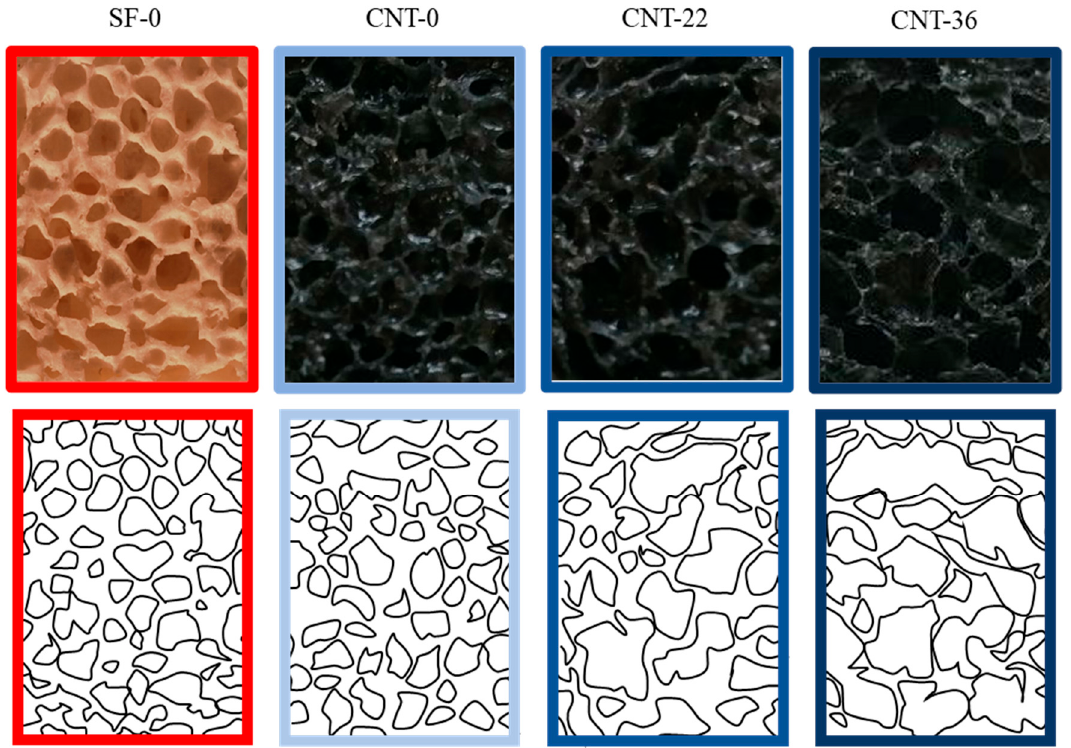
Figure 4. Cross section images along the foaming direction of the composite foams and the digital image processing of their macroporosity.